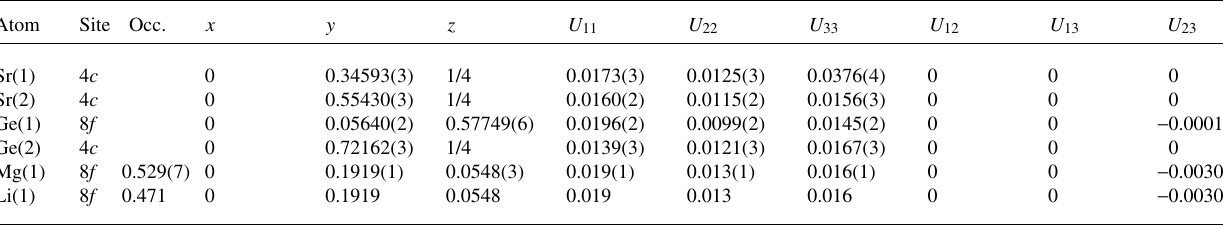
Table 4. Atomic coordinates and displacement parameters (in Å 2 )